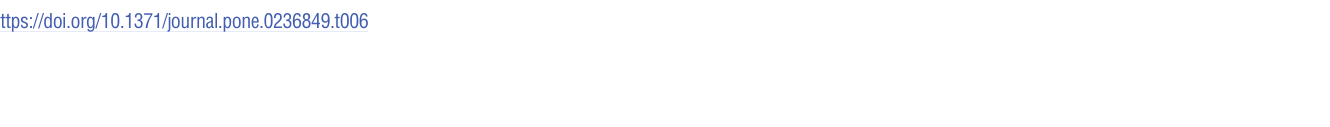
No. of DNA Sudoku 2D Pooling S-Stage Halving Gen. Binary Samples